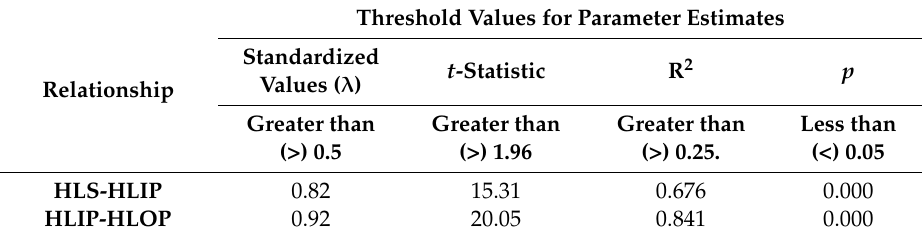
Table 12. Parameter estimates (standardized coefficients) on Factor Analysis.